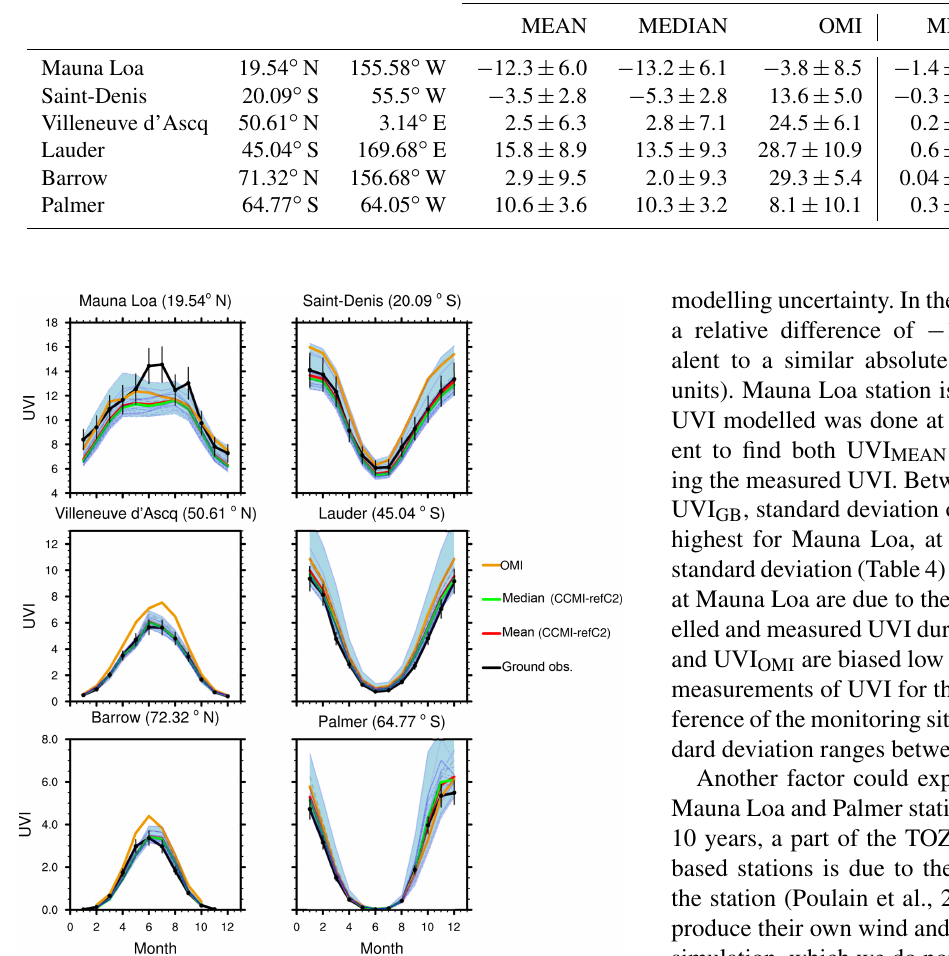
Figure 1. UVI GB (2000–2010) for six NDACC stations along with the respective closest grid point from the CCMI–TUV UVI simula- tion (UVI MEAN and UVI MEDIAN ). Station measurements are rep- resented in the black curve with a 2 σ dispersion bar. UVI MEAN and UVI MEDIAN are represented in green and red. Each CCMI model is represented in light blue; the shaded blue area represents the spread of the models. UVI OMI from the OMUVBd product is in